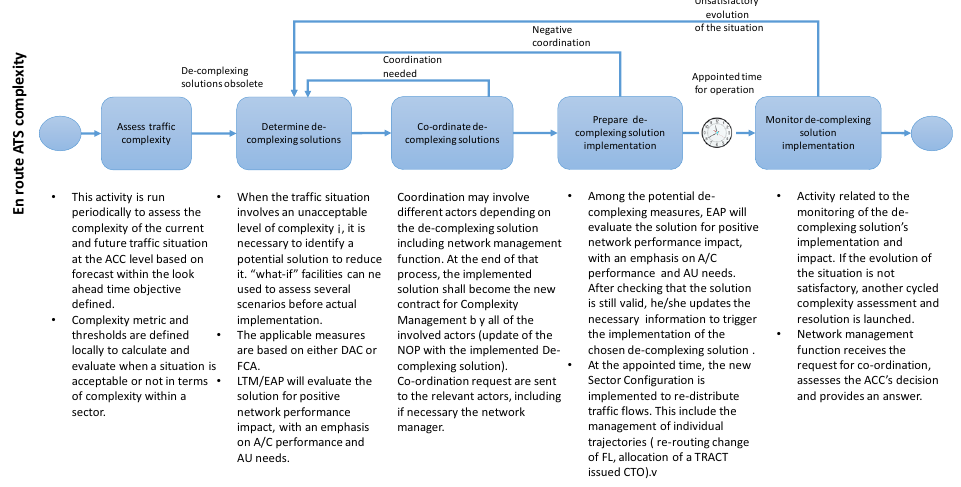
Figure 3. Manage Traffic Complexity.